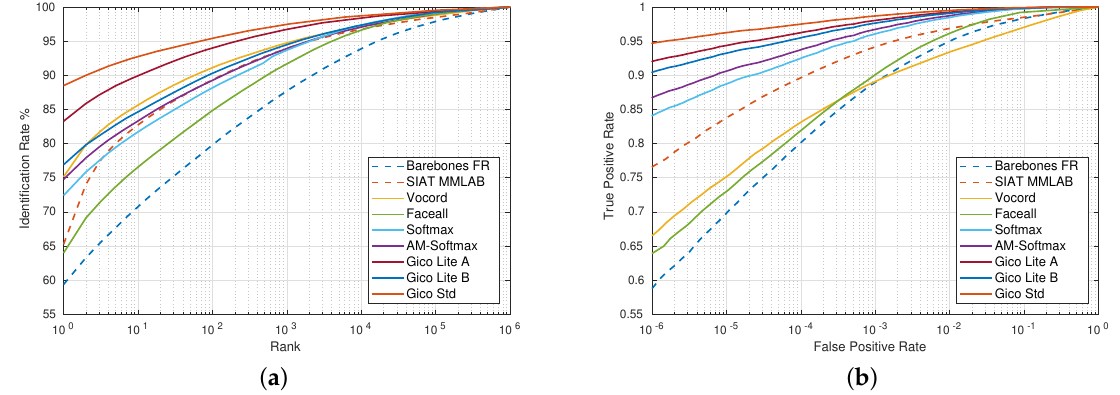
Figure 2. ( a ) The CMC curves of different methods with 1 million distractors on MegaFace Set 1. ( b ) The ROC curves of different methods with 1 million distractors on MegaFace Set